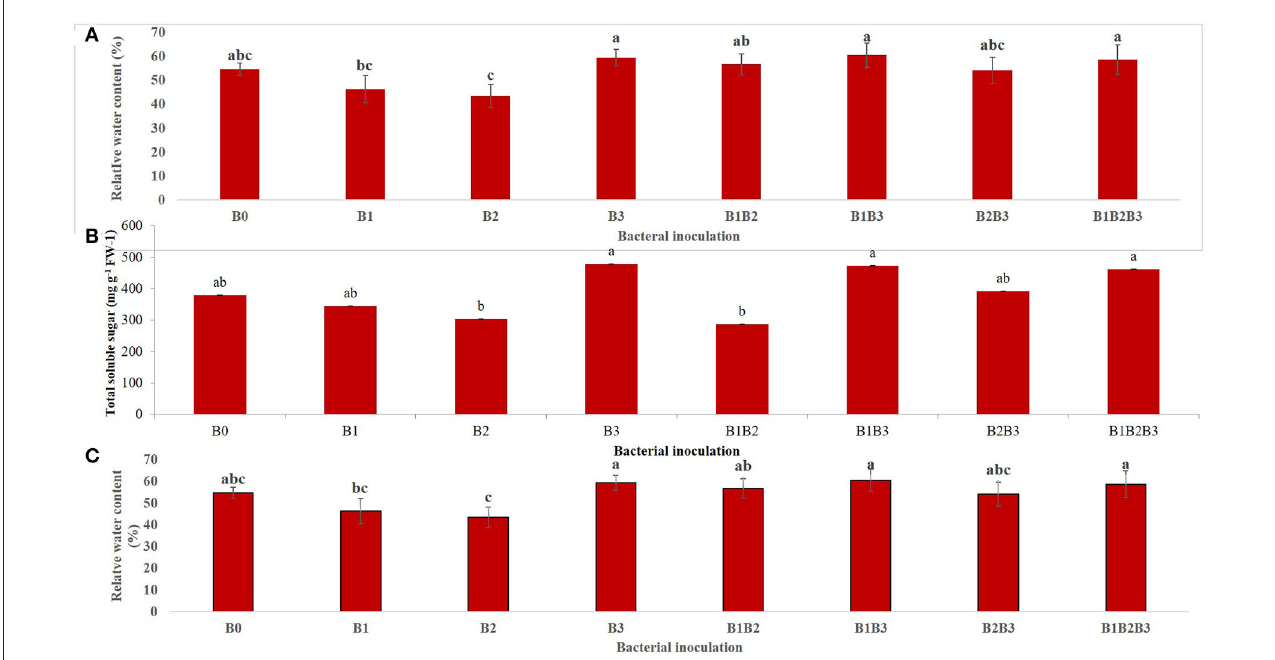
FIGURE6 Effect of bacterial inoculation on (A) relative water content, (B) total soluble sugar, and (C) soil moisture content of inoculated maize plants. Values are presented as means ± standard error ( n = 24). Means with different letters are significantly different from each other according to Tukey’s Studentized Range (HSD) test ( p ≤ 0.05). B 0 , un-inoculated control; B 1 , Pseudomonas sp. MRBP4; B 2 , Pseudomonas sp. MRBP13; B 3 , Bacillus sp. MRBP10; B 1 B 2 , Pseudomonas sp. MRBP4 + Pseudomonas sp. MRBP13; B 1 B 3 , Pseudomonas sp. MRBP4 + Bacillus sp. MRBP10; B 2 B 3 , Bacillus sp. MRBP10 +